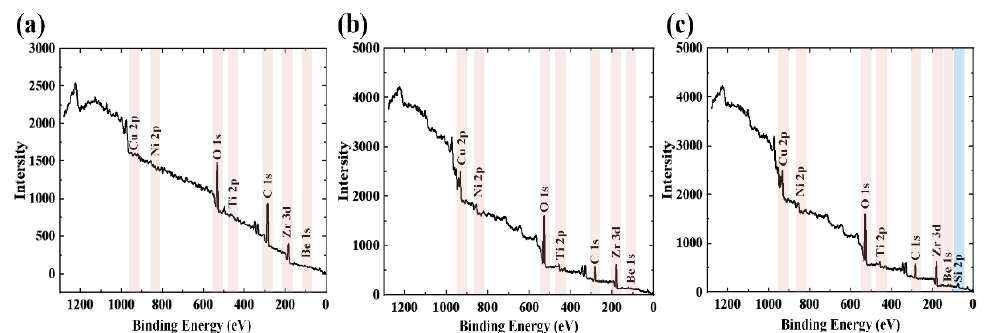
Figure 5. XPS full spectra of ( a ) untreated BMG surface; ( b ) laser-structured BMG surface; ( c ) laser- heat-treated BMG surface.